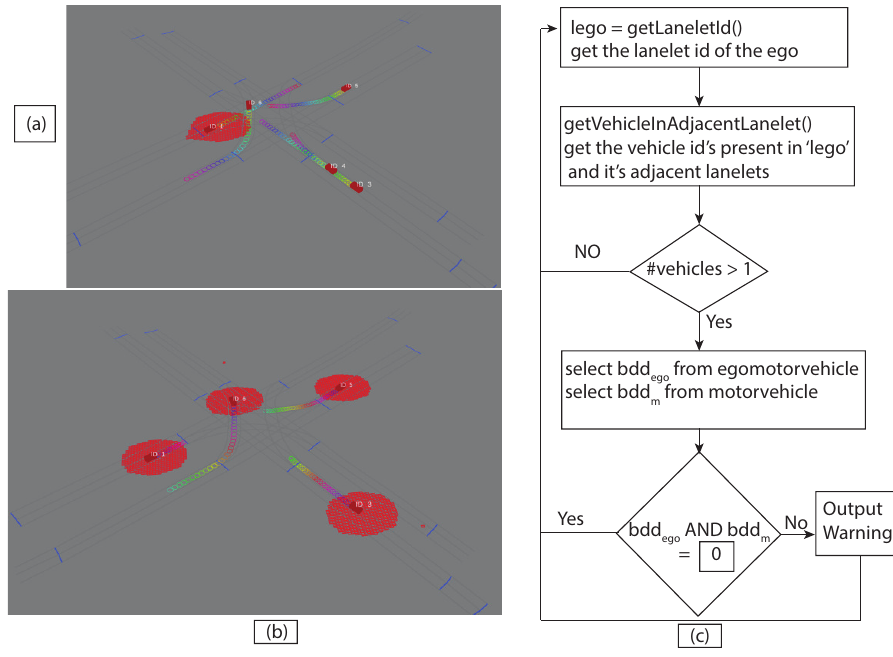
Figure 13. ( a ) Projected reachable Geohash for the vehicle at t ∈ { 0.3,0.7,1.2 } s. ( b ) Projected reachable Geohash for the vehicles at t ∈ { 0.4,0.8,1.2 } s. ( c ) Flow chart to avoid collision using BDD in the LDM setup.